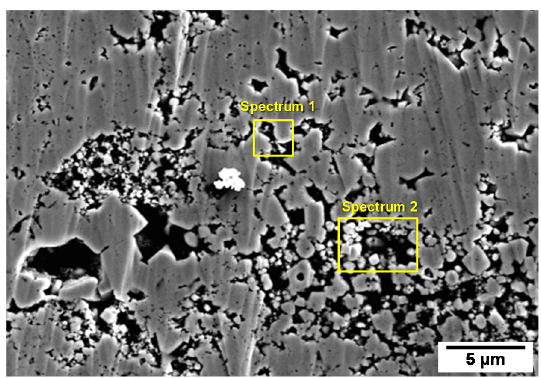
Figure 3. SEM-EDS analysis of the impurities within the pores on the tube side of the SG flakes. Table 4. Chemical composition of impurities in the pores formed on tube side of SG flakes using SEM- EDS analysis (wt.%).